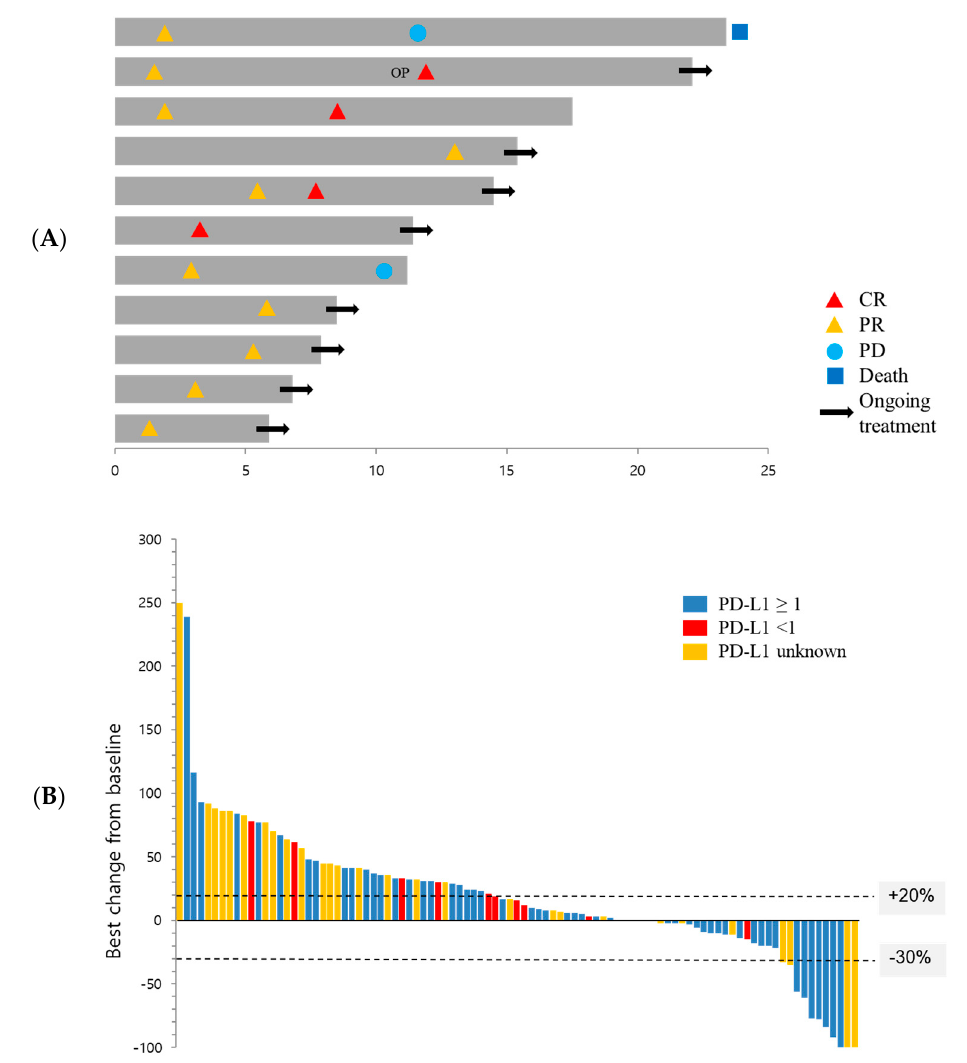
Figure 2. Antitumor activity of pembrolizumab. ( A ) Time to and duration of response in patients whose best overall response was CR or PR ( n = 11). The length of bars represents the time to the last image assessment. ( B ) Waterfall plot showing the distribution of the best percentage change in the sum of the target lesion size from baseline according to Response Evaluation Criteria in Solid Tumors (RECIST) version 1.1 ( n = 95). OP, operation; CR, complete response; PR, partial response; PD, progressive disease; PD-L1, programmed death-ligand 1.